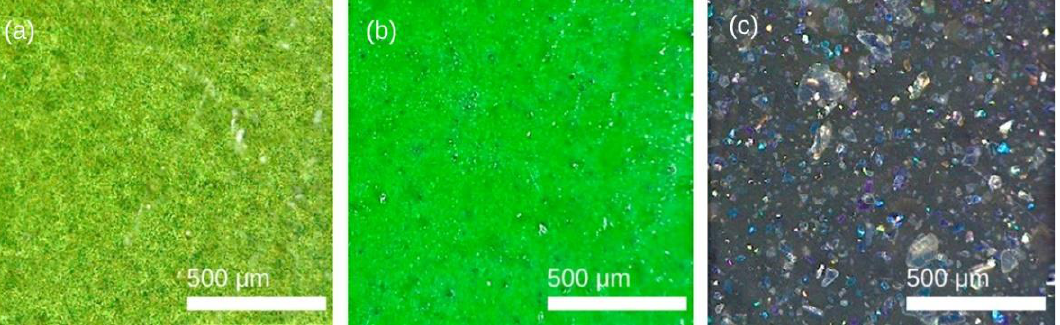
Figure 2. 2D images of coatings obtained by confocal Leica DVM6 microscope: ( a ) PFA-base, TF-76521, ( b ) FEP-base, TF-3531, ( c ) PTFE-base, TF-851 E.